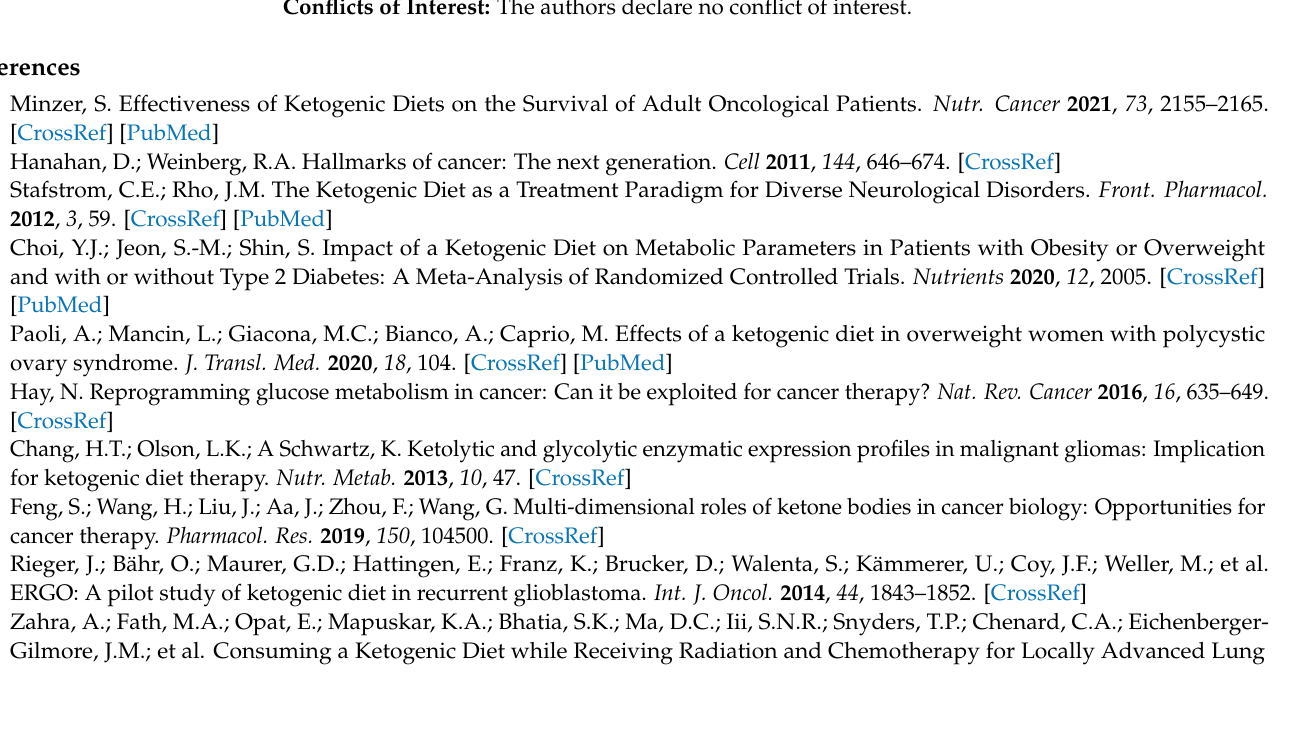
body composition; Figure S2: Supplementary analysis of effects on blood glucose, insulin and IGF-1; Figure S3: Supplementary analysis of effects on lipid profiles; Figure S4: Supplementary analysis of effects on ketosis Figure S5: Supplementary analysis of effects on creatinine; Table S1: Database, Terms and Literature number; Table S2: Characteristics of included studies; Table S3: GRADE evidence